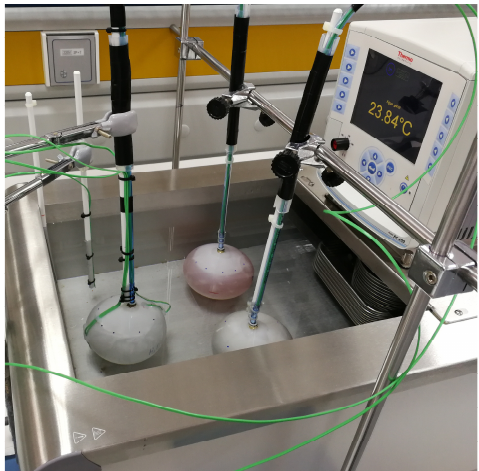
Figure 5. Experimental setup for the study of the melting and freezing cycles of isolated nodules. The image shows three nodules with S10, the phase change materials (PCM) developed within the project, and water (as a reference), with the temperature probes in the thermostatic bath.